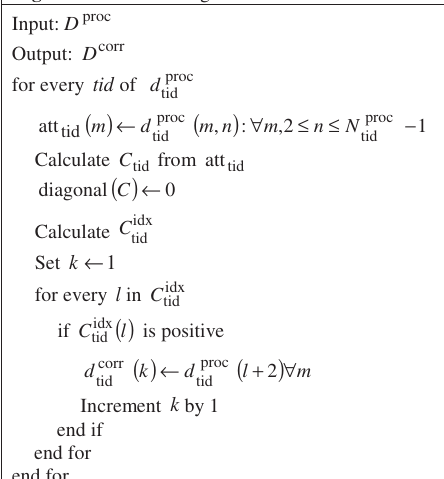
Algorithm 2: Extracting relevant attributes